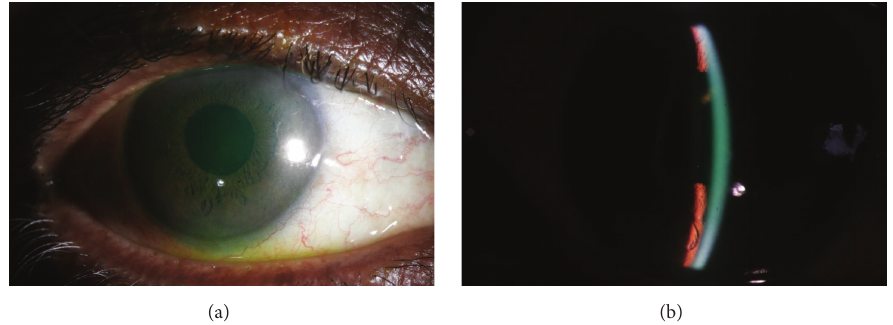
Figure 1: Slit lamp photograph of the left eye of the patient in Case Report 1 with shallow anterior chambers.